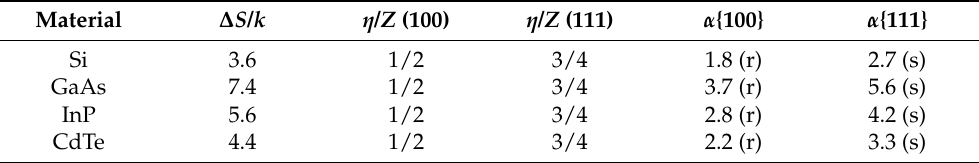
Table 1. Jackson factor α at the melting point of some semiconductors (adapted from [3]).